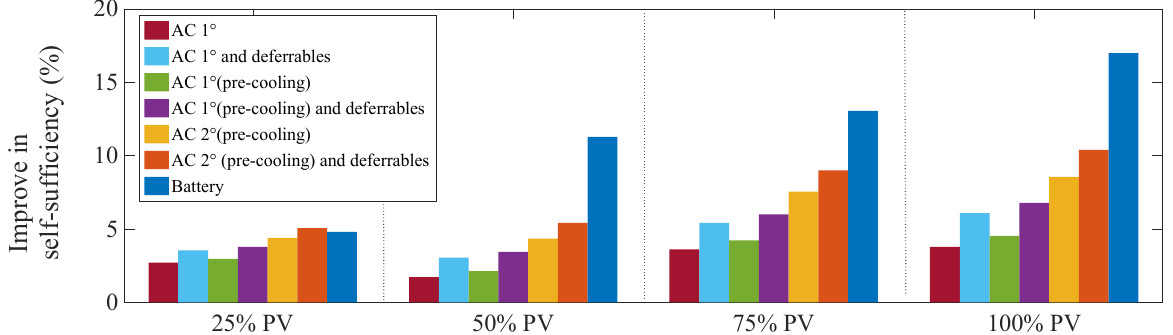
Figure 13. Comparison of self-sufficiency improvement with different user adaptation modalities and battery integration.